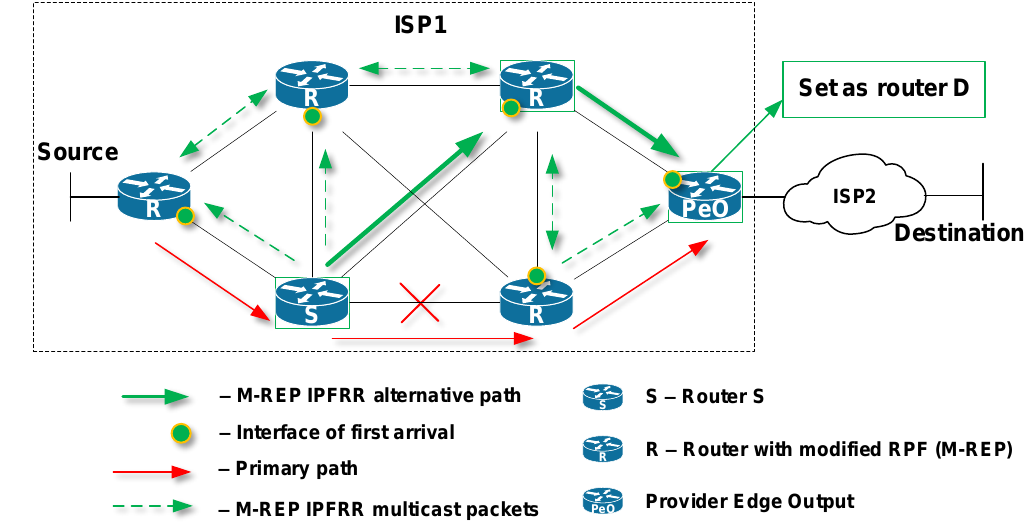
Figure 12. Manual configuration of Router D.